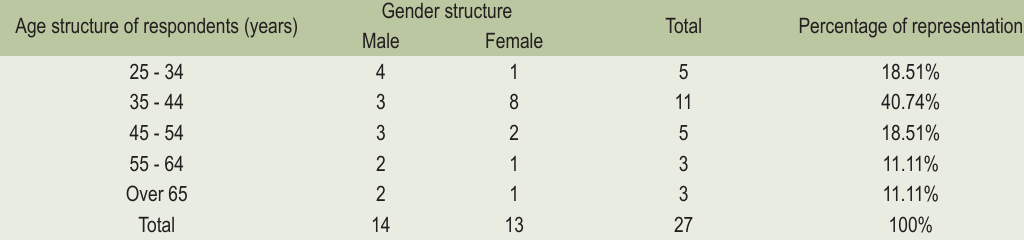
TABLE 1. Gender and age structure of respondents with acute lumbar pain syndrome